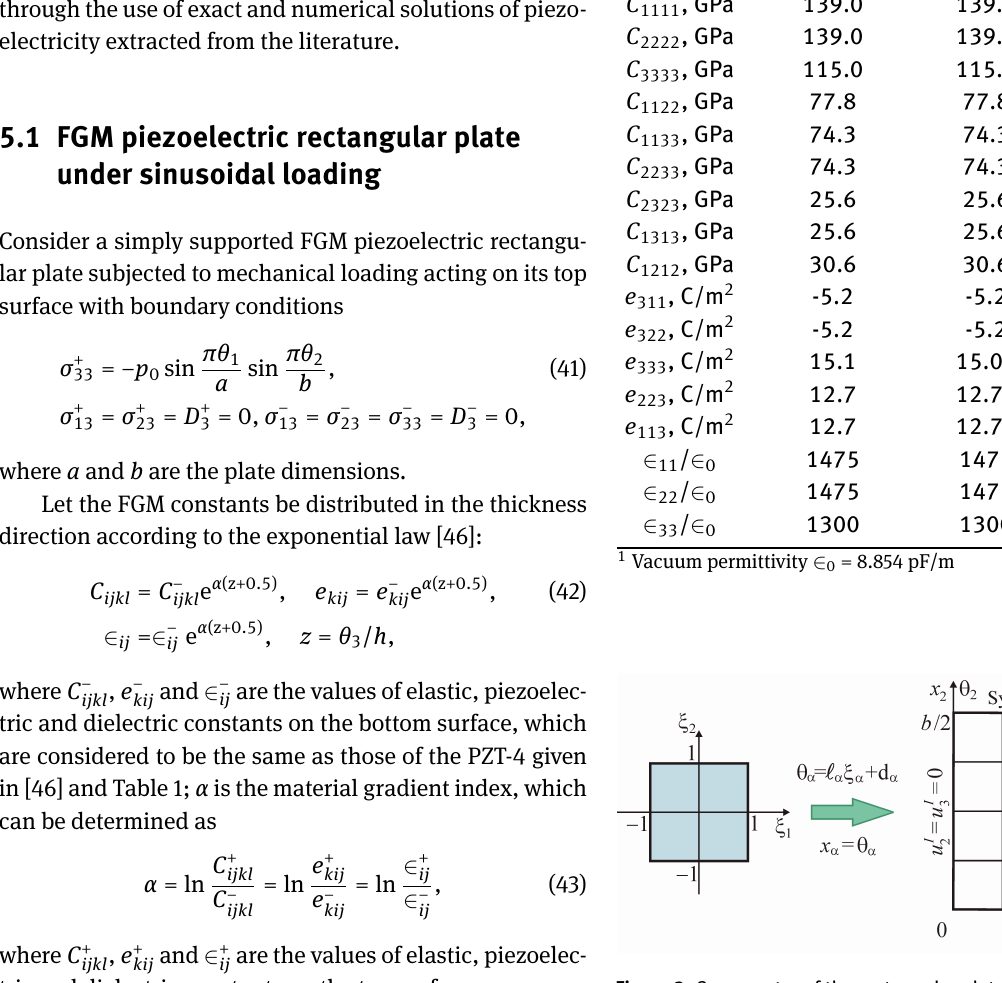
Figure 3: One quarter of the rectangular plate discretized by uniform 4 n × 4 n meshes, where the mesh parameter n = 1, 2, 4, 8, 12 and